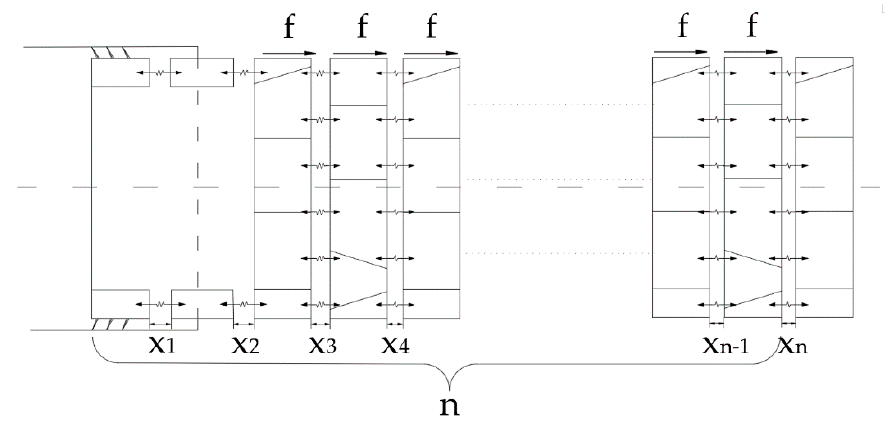
Figure 2. Schematic diagram of segment rings and circumferential joints after thrust unloading.